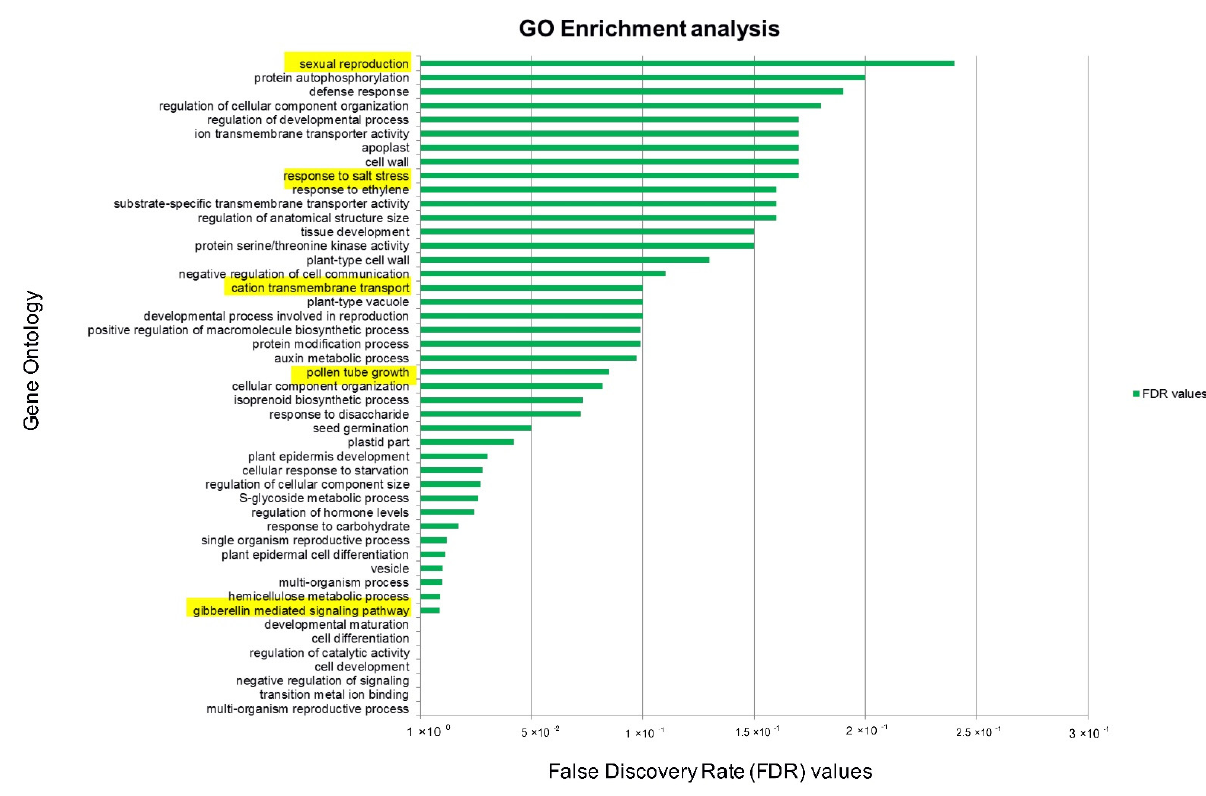
Figure 3. Gene set enrichment analysis shows enriched GO categories based on differentially ex- pressed genes between the tolerant genotype and sensitive genotype flowers in response to salt